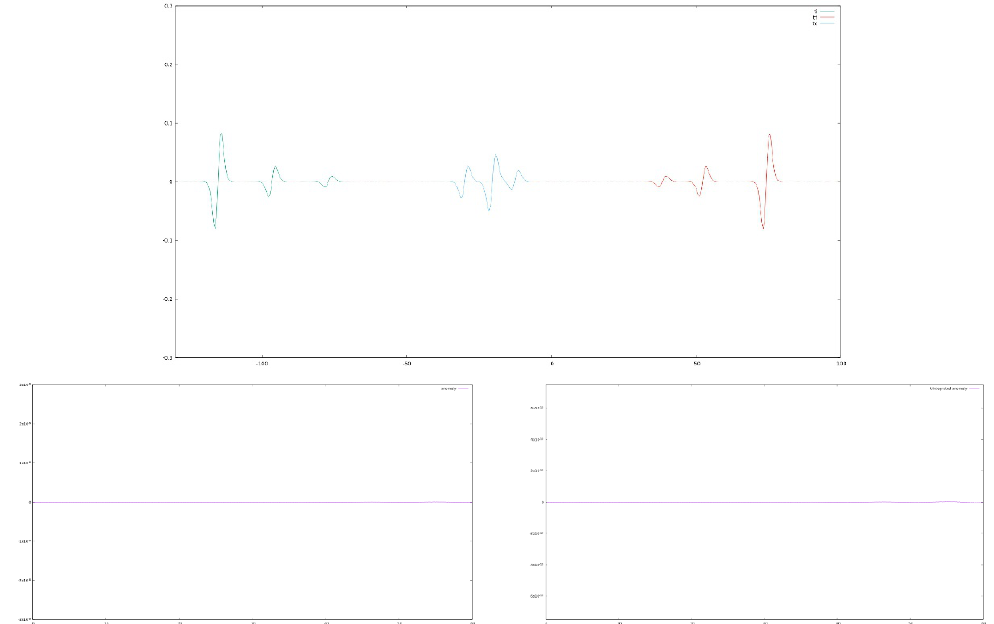
Figure 10 . Top (cid:12)gure shows the anomaly density of (cid:11) 3 in (4.24); i.e. the function ( w x v t u t ) plotted in x -coordinate for three successive times, t i = before collision (green), t c = collision (blue) and t f = after collision (red), for the 3-soliton of (cid:12)gure 3. Bottom (cid:12)gures show the plots of the anomaly (cid:11) 3 vs. t and the t -integrated anomaly R t (cid:11) 3 vs. t , t i